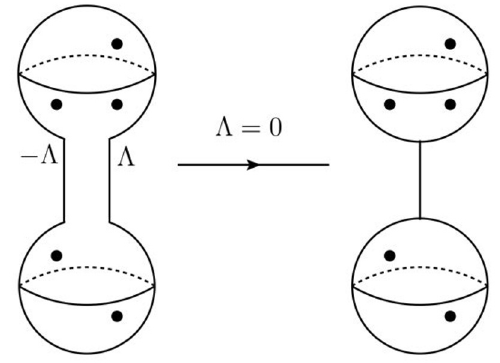
Figure 1 . Factorization